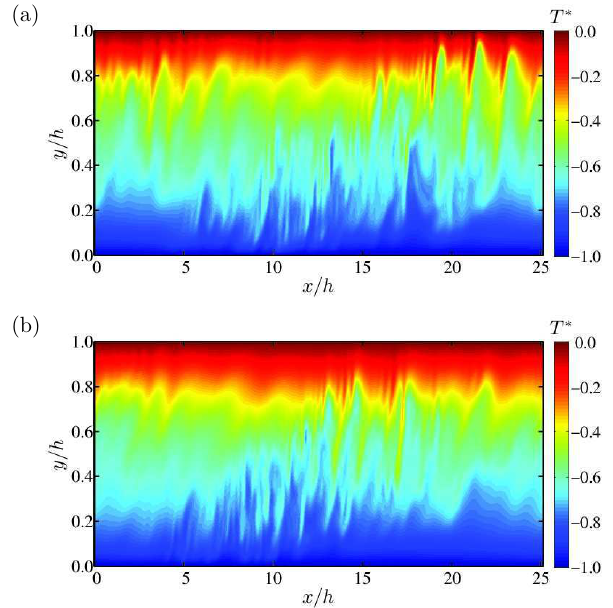
Figure 13. Instantaneous contours of temperature at the mid- spanwise plane (not to scale, Re τ = 180). (a) Ri τ = 120, z/h = 2 π , (b) Ri τ = 240, z/h = 2 π .